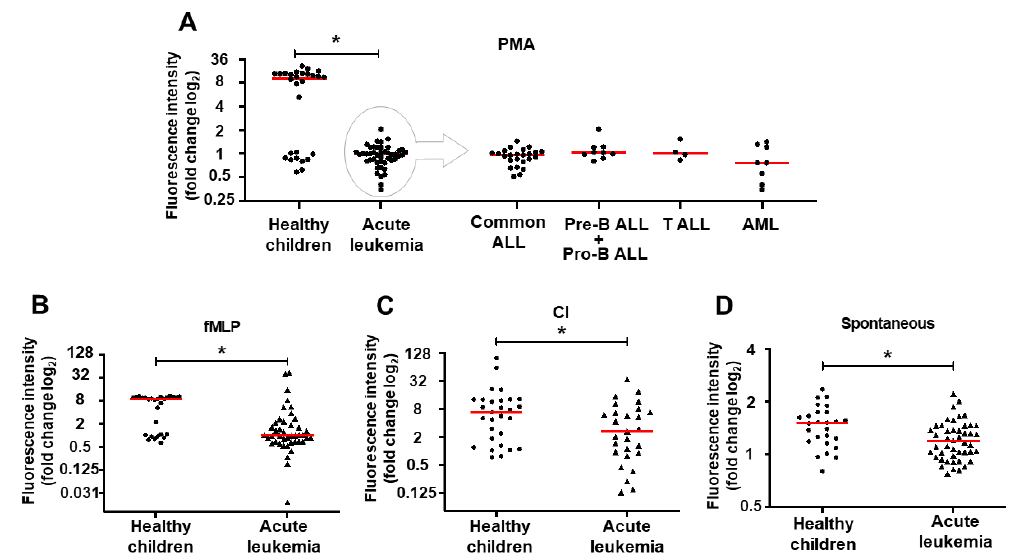
Figure 1. Neutrophil extracellular trap (NET) release is impaired in children with acute leukemia. Each dot and triangle on scatter plots represent the result for an individual patient. Red horizontal lines represent median value for each group. Statistical significance is shown by asterisk over a horizontal bar over the analyzed groups. In vitro NET formation after induction with phorbol 12-myristate 13-acetate (PMA) ( A ), N-formyl-methionyl-leucyl-phenylalanine (fMLP) ( B ), calcium ionophore (CI) ( C ) or spontaneously released after 3 h of incubation ( D ). Data expressed as a log2 fold change in extracellular DNA fluorescence intensity as compared to non-induced sample. * p < 0.05 in Mann–Whitney non-parametric 2-tailed test.